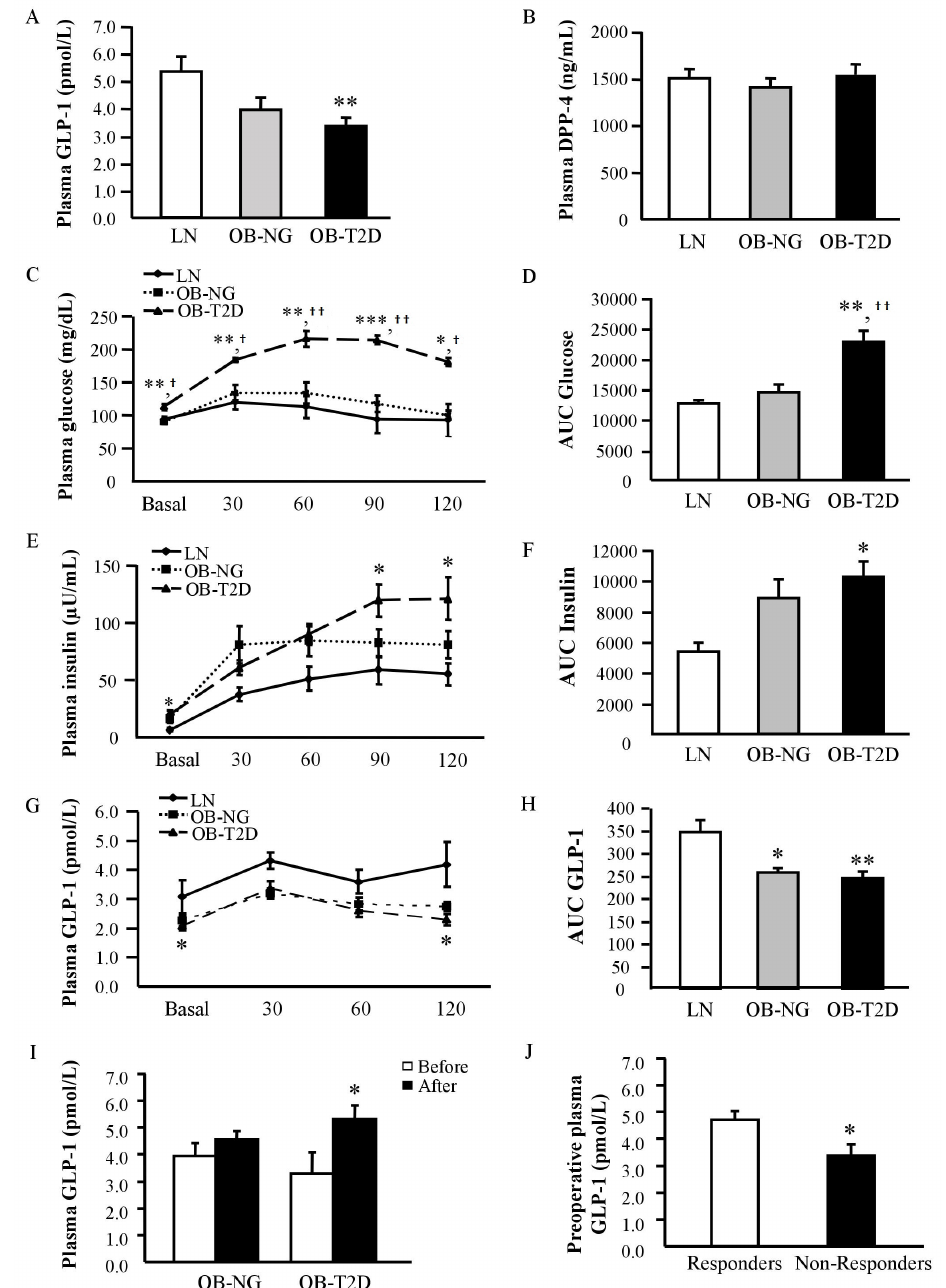
Figure 1. ( A ) Circulating GLP-1 and ( B ) DPP-4 levels in lean (LN) volunteers, obese normoglycemic (NG) and obese patients with type 2 diabetes (T2D). Plasma glucose ( C ), insulin ( E ) and GLP-1 ( G ) concentrations during an OGTT in LN volunteers, obese NG and obese subjects with T2D as well as the area under the curve (AUC) for glucose ( D ), insulin ( F ) and GLP-1 ( H ), respectively. Data represent the mean ± SEM. Differences between groups were analyzed by one-way ANOVA followed by Tukey’s tests. * p < 0.05, ** p < 0.01, *** p < 0.001 vs. LN subjects. † p < 0.05, †† p < 0.01 vs. obese NG subjects. ( I ) GLP-1 concentrations in obese patients before and after Roux en-Y gastric bypass (RYGB) and ( J ) comparison of pre-surgical GLP-1 levels in obese patients with T2D classified according to their response to RYGB regarding T2D remission. Bars represent the mean ± SEM. Differences between groups were analyzed by paired or unpaired two-tailed Student’s t tests, where appropriate. * p < 0.05 vs. pre-surgical values or responder